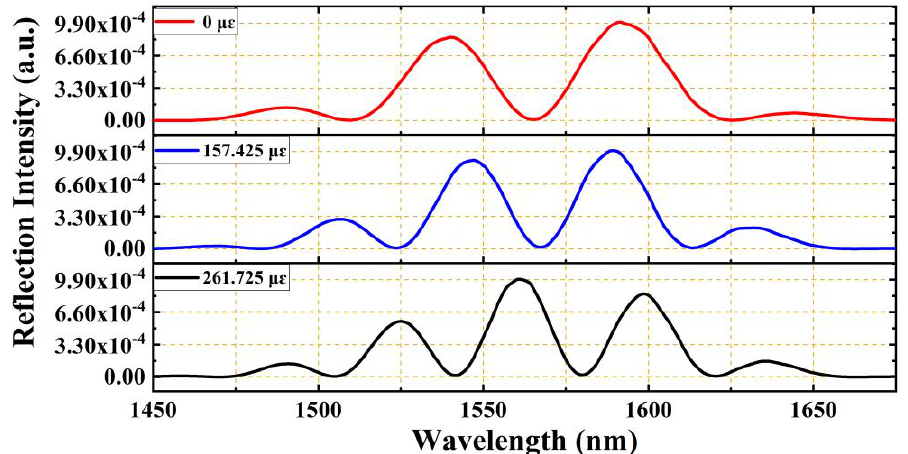
Figure 5. Spectral shift upon application of a longitudinal strain to a short cavity EFPI strain sensor with a microcavity length 20 µm of and a capillary length of 40 mm. The three reflection spectra were gotten under different strains of 0, 157.425, and 261.725 μ ɛ , respectively. With the increasing of the strain imposed, more reflection peaks appeared in the spectra for the increasing of cavity length.